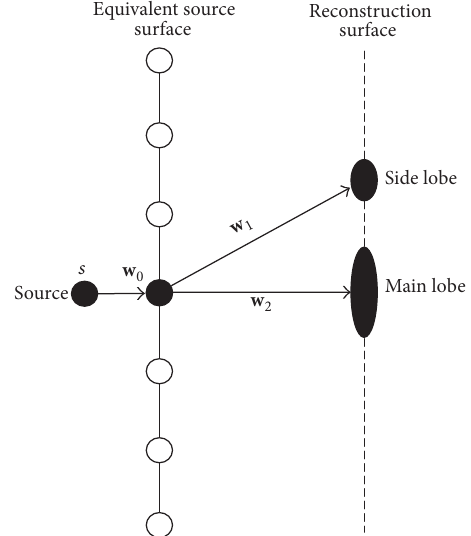
Figure 2: The model of single source.